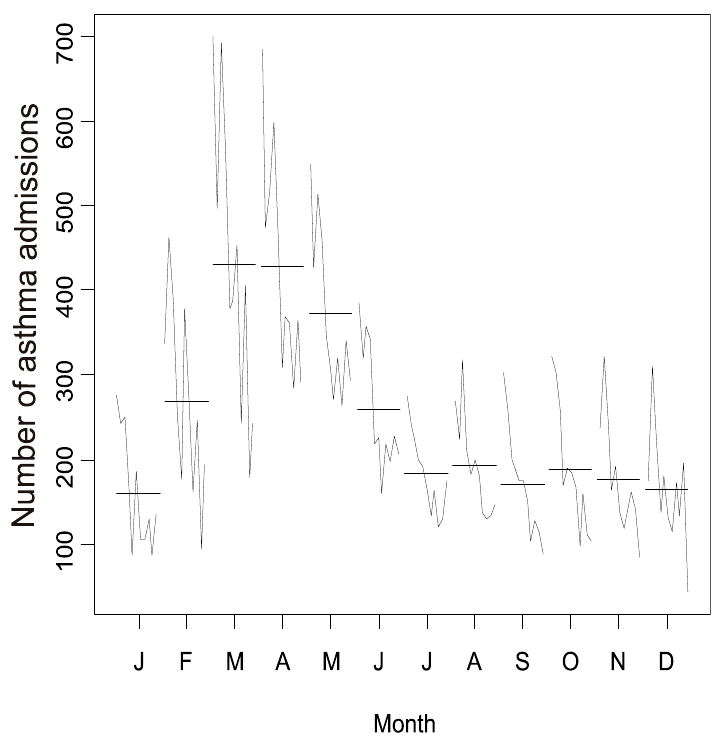
Figure 7. Seasonal subseries plot of asthma hospitalizations in children and adolescents aged 0–14 years in Belo Horizonte, Minas Gerais, Brazil, 2002–2012.